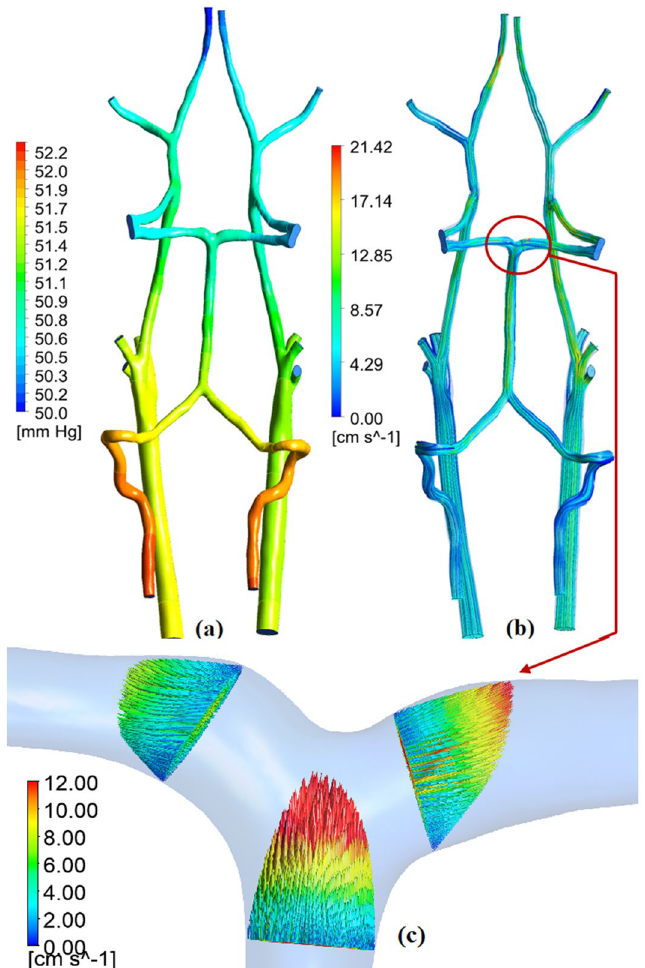
Figure 3. CFD simulation results for one of animals: ( a ) Pressure distribution on the wall of the circulatory system, ( b ) Stream lines of the velocity vector, ( c ) Velocity field on cross-sectional planes: №2, №12,